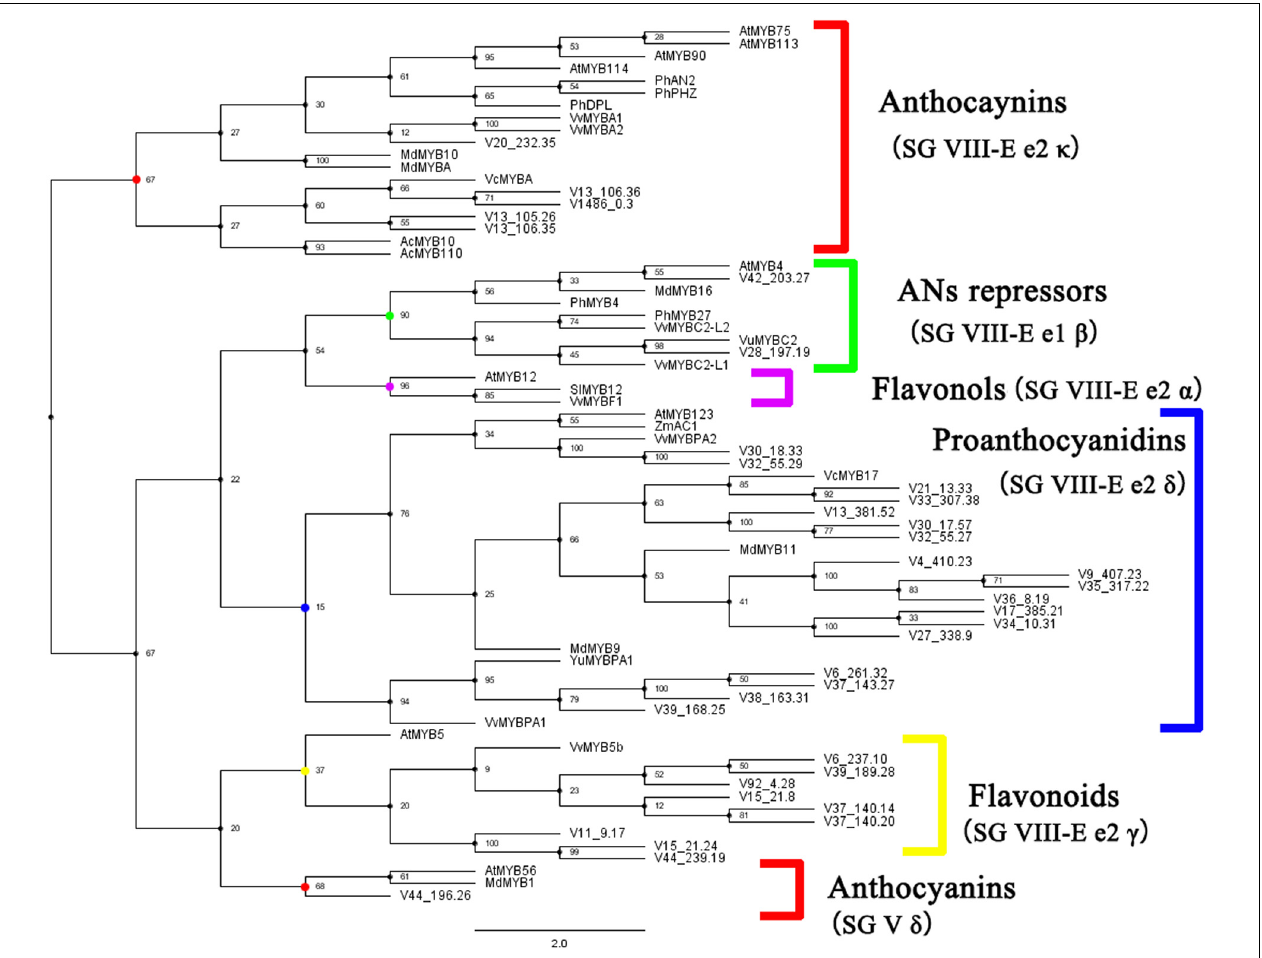
FIGURE 5 | Identification of known MYB transcription factors regulating anthocyanin synthesis in blueberry. Phylogenetic tree of MYB transcription factors was constructed in whole nucleic acid sequences using maximum likelihood tree with 1,000 bootstrap in IQ-tree. The optimal alternative model was selected after calculation by